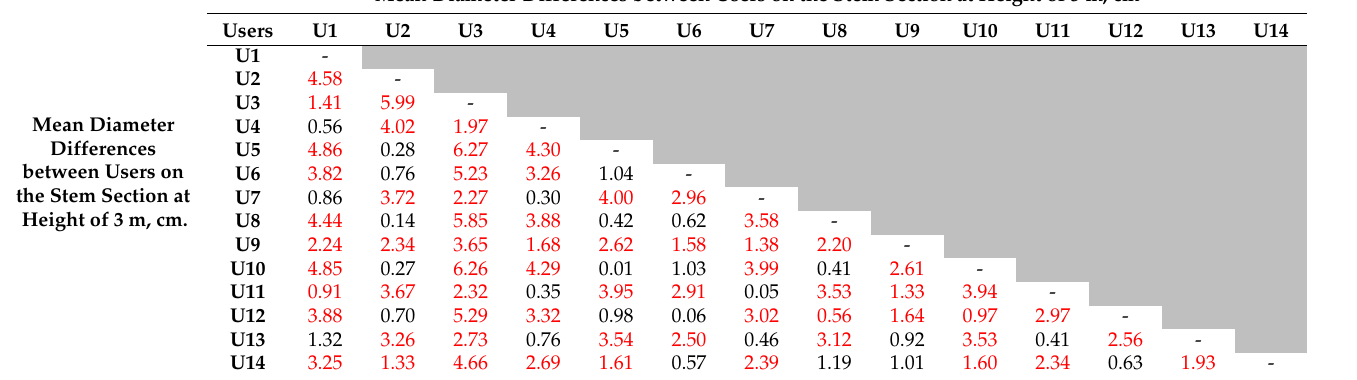
Table A2. Differences between mean diameters obtained by each user when a laser caliper was used to measure upper-stem diameters at a height of 3 m. The red values denote significant differences between the mean diameters obtained by the users.